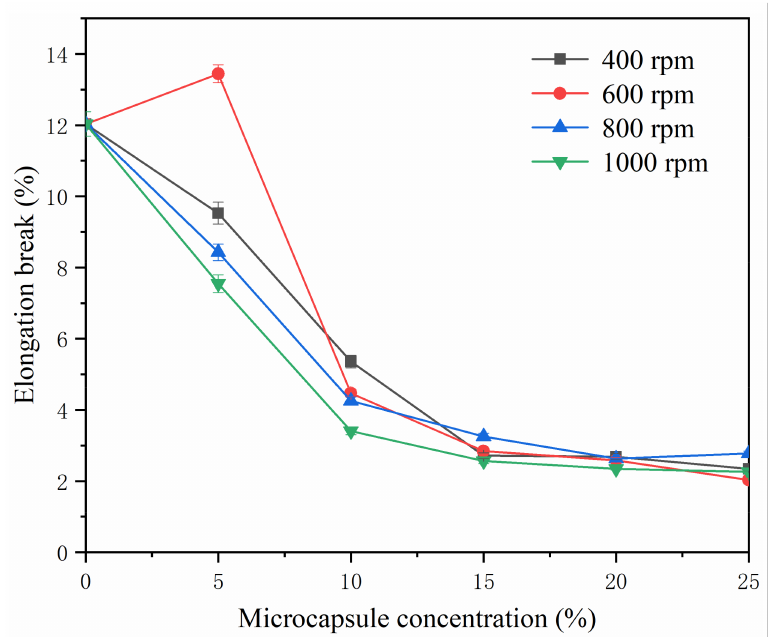
Figure 7. Effect of the microcapsules on the elongation at